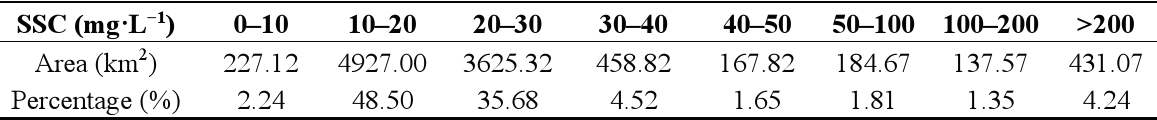
Figure 8. The image map of SSC distribution derived from the atmospherically-corrected TM data using the semi-analytical model for the Gulf of Bohai. Table 7. Statistics of SSC levels derived from the atmospherically-corrected TM data using the semi-analytical model in different